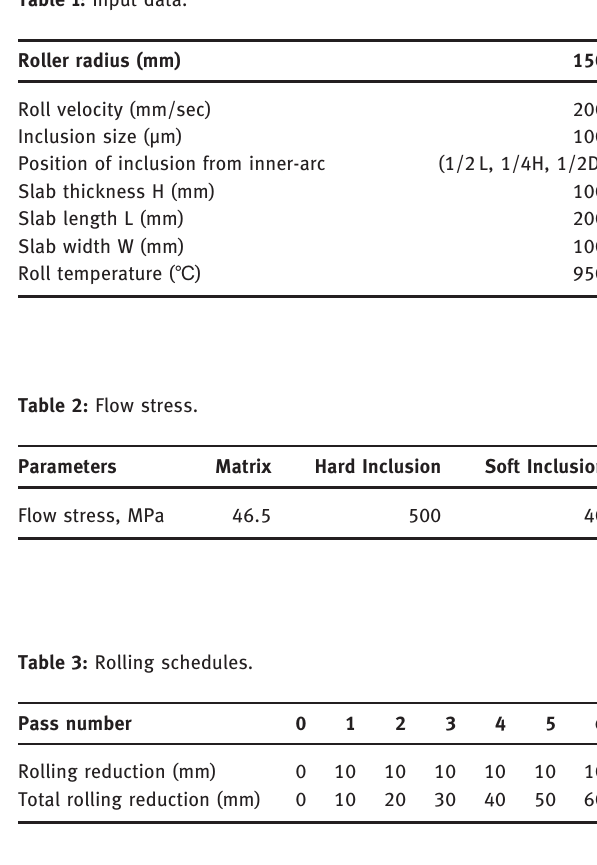
Table 1: Input data.